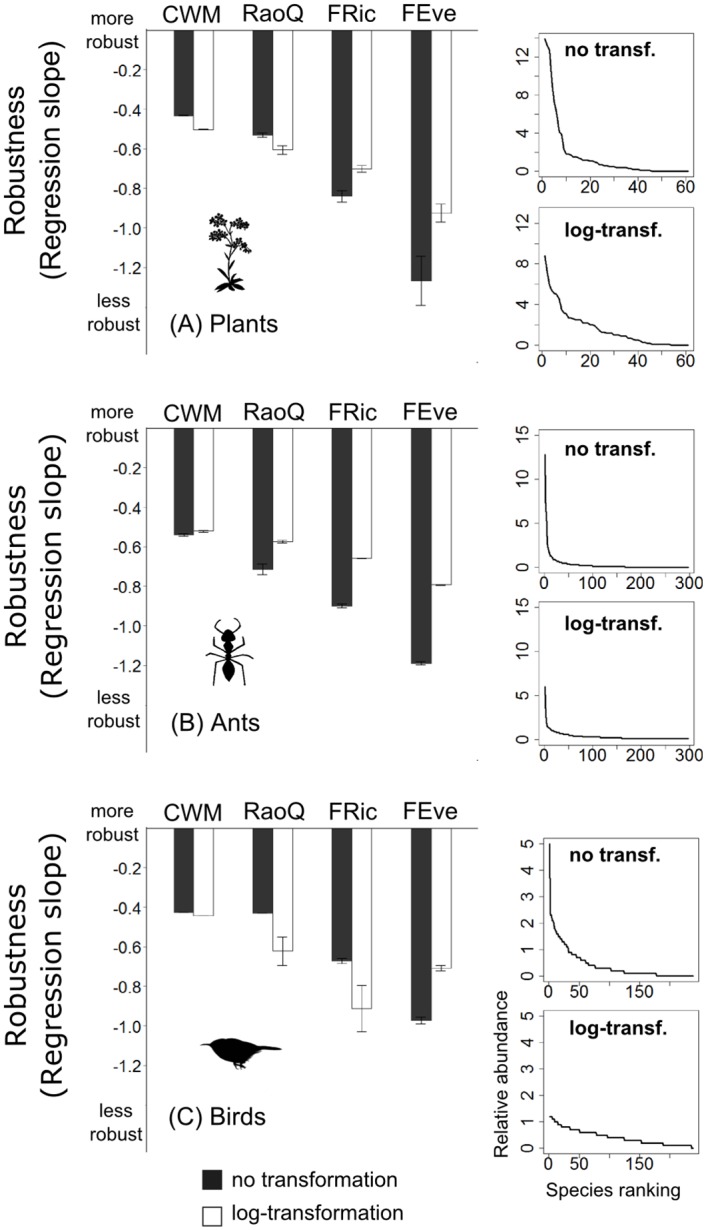
Effect of abundance transformation on FD index sensitivity.Barplots showing the results of linear mixed effects models, specifically the effect of the abundance transformation on the slopes for the three different types of organisms. The more negative the regression slope, the more sensitive the particular index is to missing trait information. The error bars denote the 95% confidence intervals. (A) plant community (n = 12 plots), (B) ant community (n = 58 plots), and (C) bird community (n = 8 plots). The right panels depict dominance-diversity curves for the respective organism dataset before and after log-transformation.